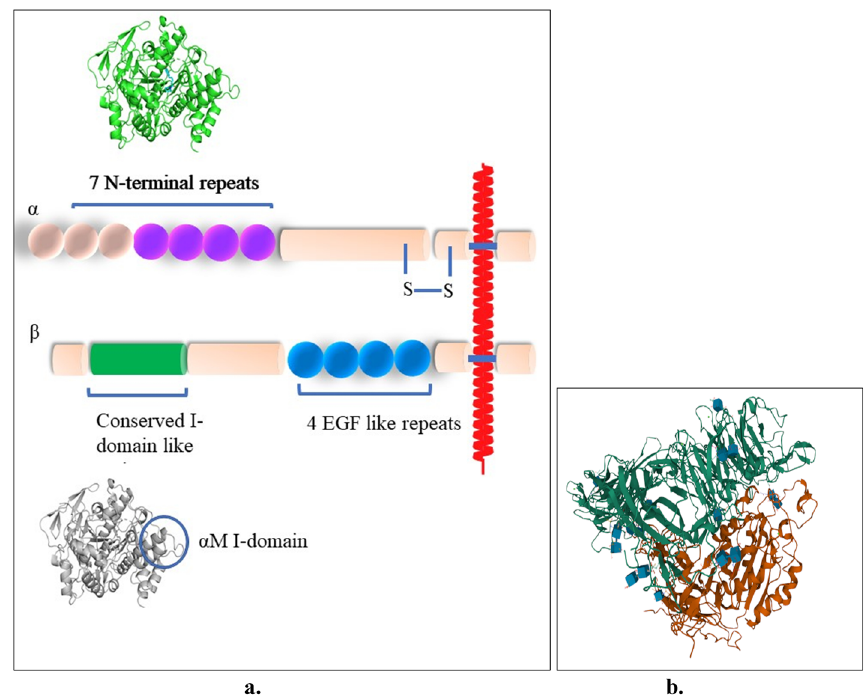
Figure 3: ( a ) Schematic diagram of an integrin α – β heterodimeric structure. Seven α subunits N - terminal repeats with the last four containing EF - hand - like divalent cation - binding sites. The seven repeats fold to form the β propeller part ( β - sheets labeled as W1 – W7 ) . The putative I - domain - like structure of the integrin β subunit is also shown. The α M I - domains illustrate Rossmann folds as adopted by β I - domains. Down from the putative β I - domain - like motif are located four cysteine - rich epidermal growth factor - like repeats, inspired and with permission from Humphries [ 7 ] ; ( b ) the crystal structure of the extracellular segment of the integrin ανβ 3 with no bound RGD peptide. Source: Protein Data Bank, PDB code 1JV2 ) [ 14,21 ]